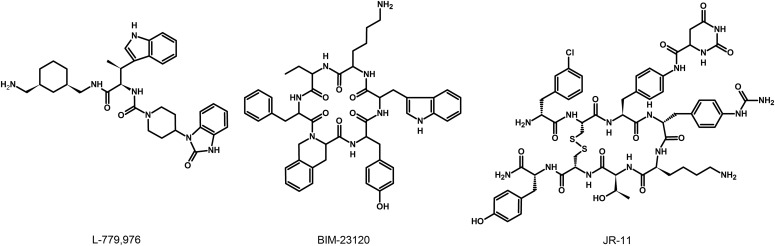
Structures of synthetic SST2 ligands. L-779,976 and BIM-23120, SST2 agonists; JR-11, SST2 antagonist.